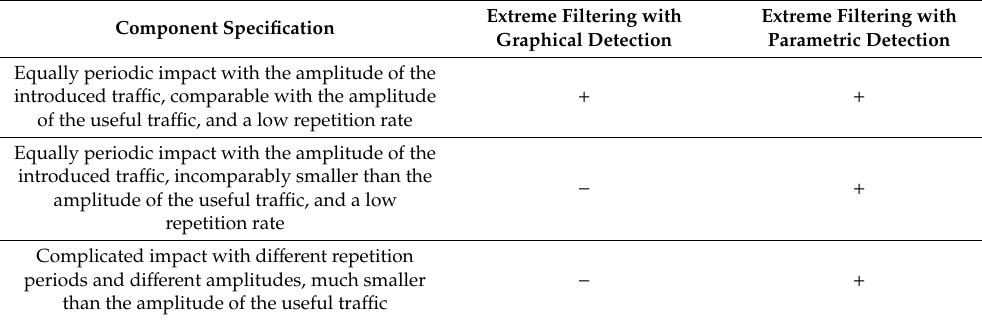
Table 1. Comparative evaluation of the sensitivity of extreme filtration